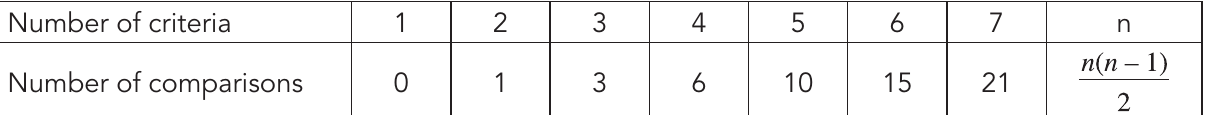
Table IV: Number of